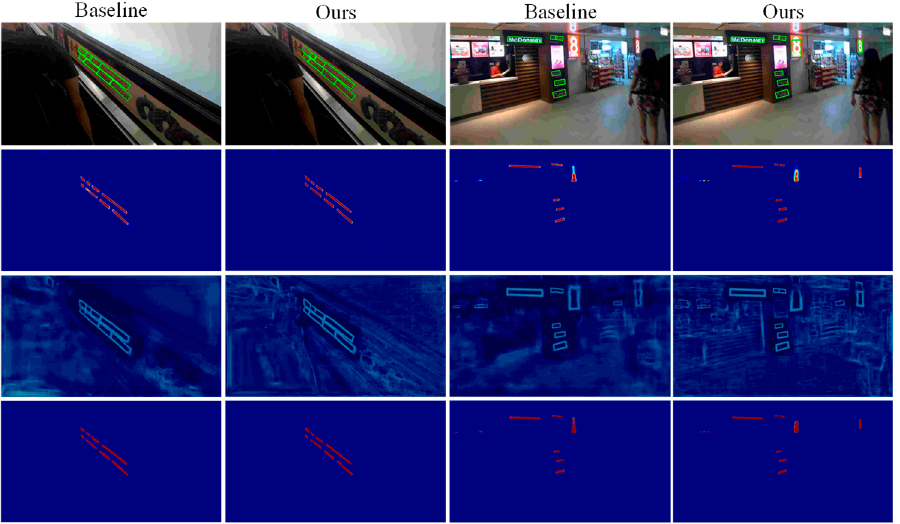
Figure 6. Visualization results of baseline and ours. Table 6. Test results of curved text dataset. The value in brackets refers to the height of the input image. “*” means multi-scale test. “MTS” and “PSE” are the abbreviations for Mask TextSpotter and PSENet.